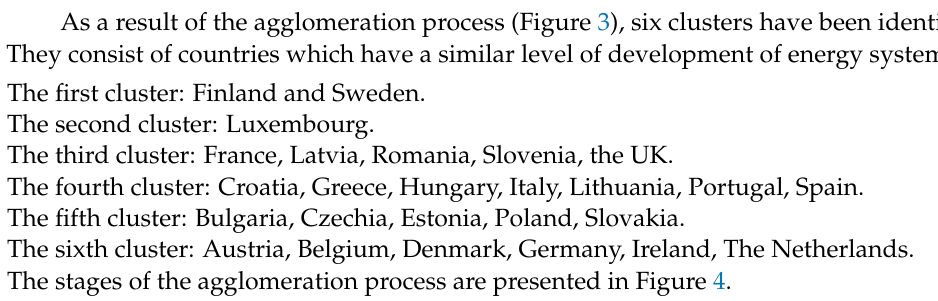
The stages of the agglomeration process are presented in Figure 4.